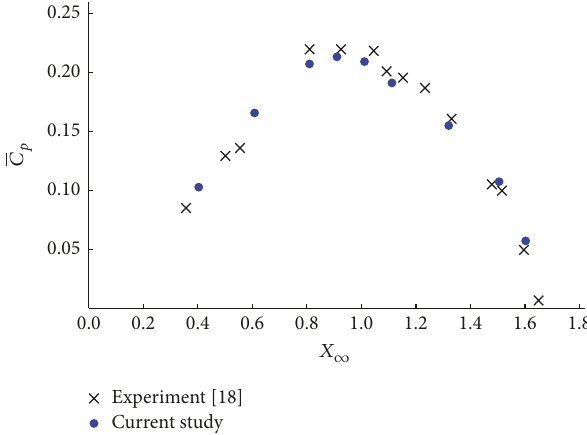
Figure 9: Comparison of computed power coefficients 𝐶 𝑃 for a two-bucket Savonius rotor at Re = 1.96 ⋅ 10 5 with experimental data (Sheldahl et al. [17] at Re = 3.9 ⋅ 10 5 and Shankar [18] at Re = 1.96 ⋅ 10 5 ).